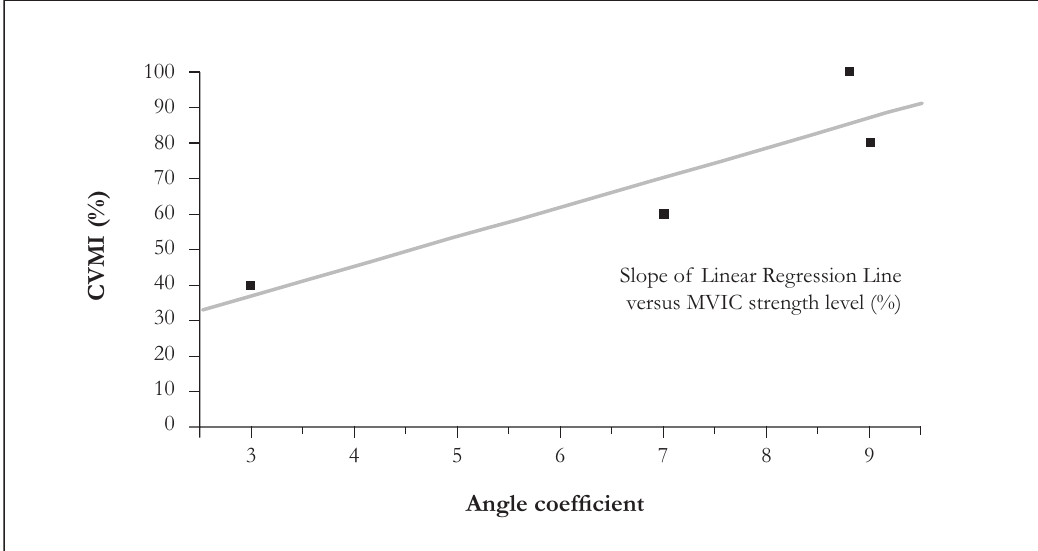
Figure 5 - Slope of linear regression line (determined by Pearson’s test) for median frequency of each strength level measured for the Vastus medialis of Volunteer 1 (abscissa axis) crossed with respective strength levels (ordinate axis). The linear regression line obtained by the slope of each strength level (100, 80, 60, 40% of MVIC) establishes a new linear regres- sion line, which crosses the ordinate axis (percentage of strength level), demonstrating the fatigue index for the muscle